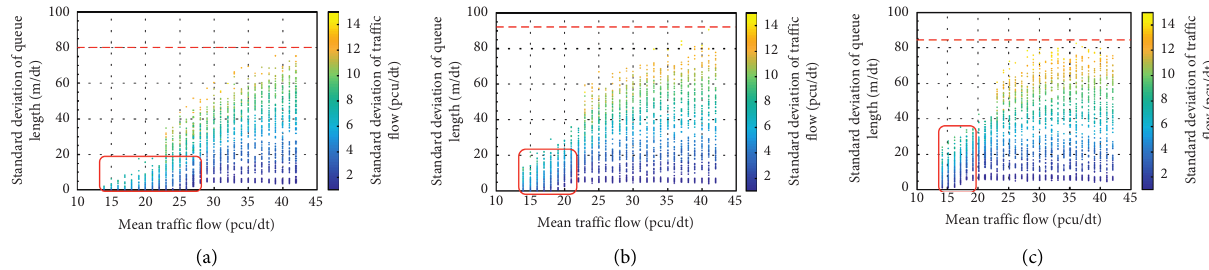
Figure 5: Standard deviation of queue length under different saturations with different intercycle flow standard deviations. (a) Dynamic control. (b) Plan selection control. (c) Pretimed control.